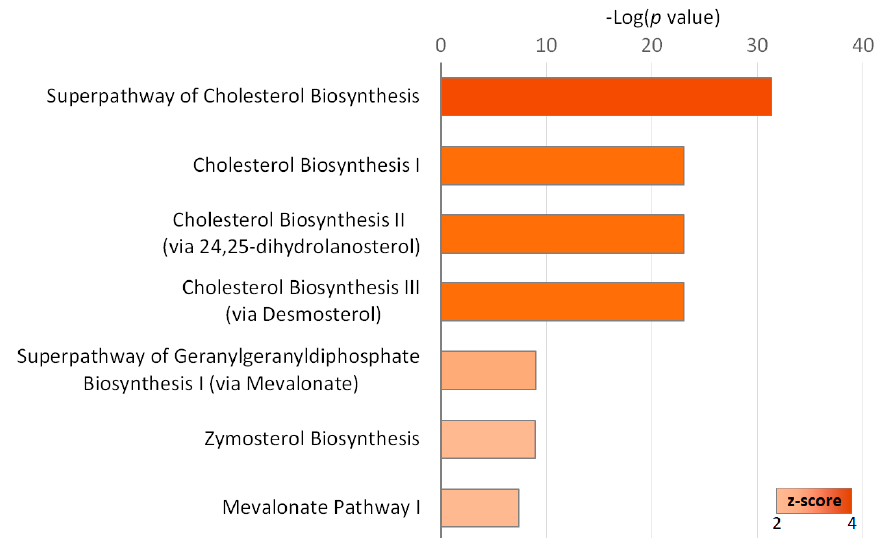
Figure 3. Canonical pathways significantly associated with the differentially expressed genes in 165 idiopathic pulmonary fibrosis (IPF) fibroblasts treated with epigallocatechin gallate (EGCG) versus 166 water. The z-score represents the magnitude of significant activation. 167 The protein–protein interaction (PPI) network analysis using the STRING database identified a 168 total of 61 nodes and 172 edges, with PPI enrichment p -value <1.0 × 10 − 16 . Using k-means clustering, 169